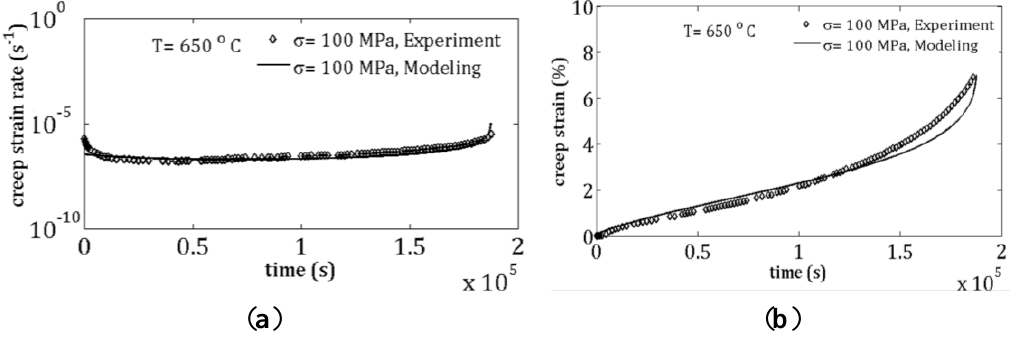
Figure 10. Creep results from experiments and finite element simulation for 100 MPa and 650 °C: ( a ) creep strain rate versus time; and ( b ) true creep strain versus time.